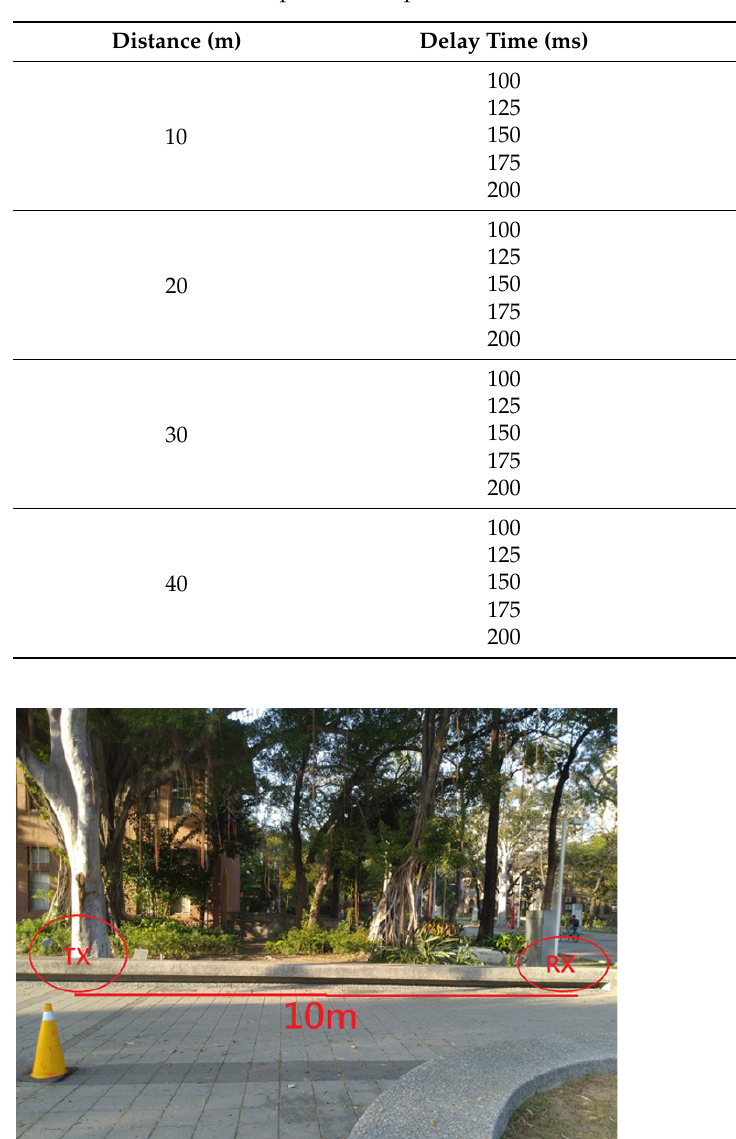
Table 1. SX LoRa-1278 reception rate experiment results.